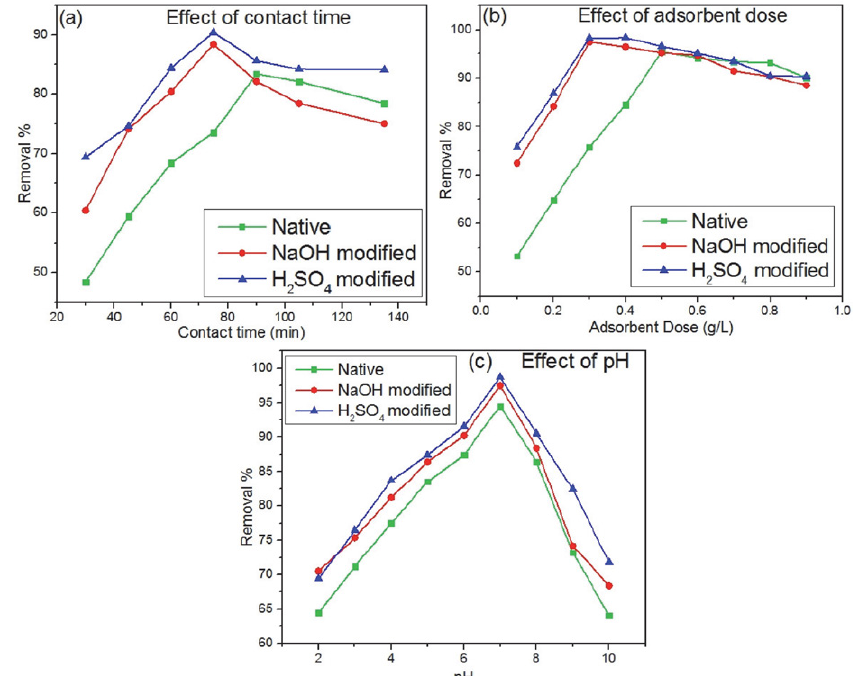
Figure 5. Influence of (a) Contact time; (b) Adsorbent dose; (c) pH on the adsorption of As(III) using native and modified brick kiln slag at 298